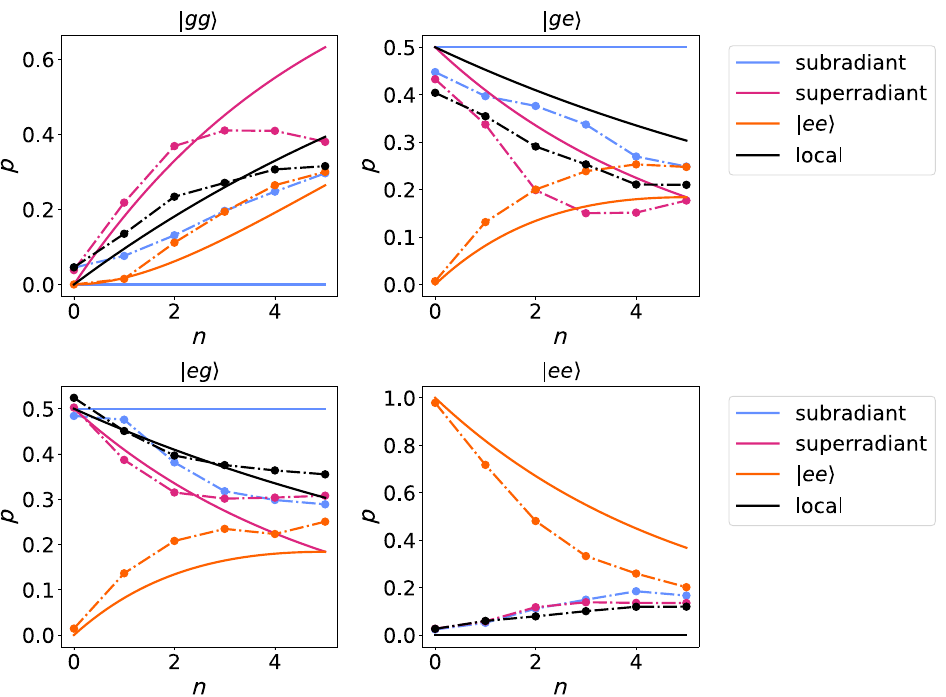
FIG. 8. The probability of finding the states | gg (cid:5) , | ge (cid:5) , | eg (cid:5) , and | ee (cid:5) through a projective measurement in the computational basis as a function of the number of steps in the MCM (second set of results), when the initial state is the subradiant state (light blue), the superradiant state (magenta), and | ee (cid:5) (orange), and when the dynamics are local, starting from the subradiant state (black). The continuous lines show the theoretical prediction based on the master equation. The markers on the dash-dotted lines are experimental values. The results are obtained as averages over 37 realizations of the protocol and the error bars are within the